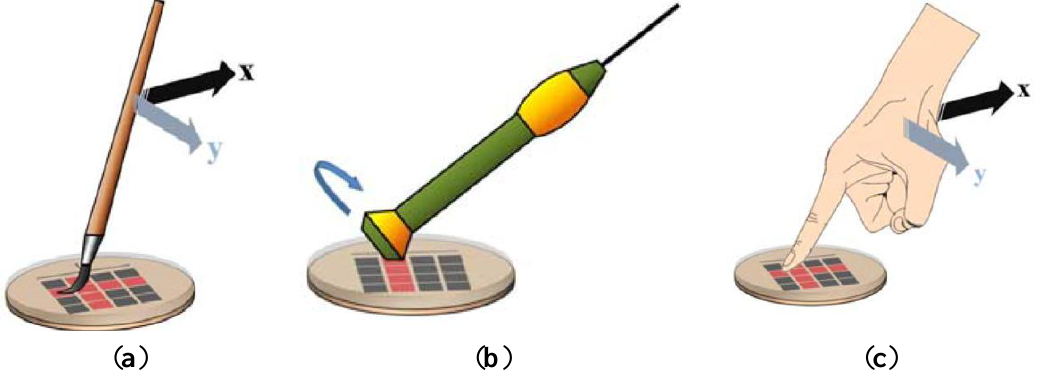
Figure 1. Touch modalities. ( a ) Paintbrush brushing; ( b ) finger sliding; ( c ) washer